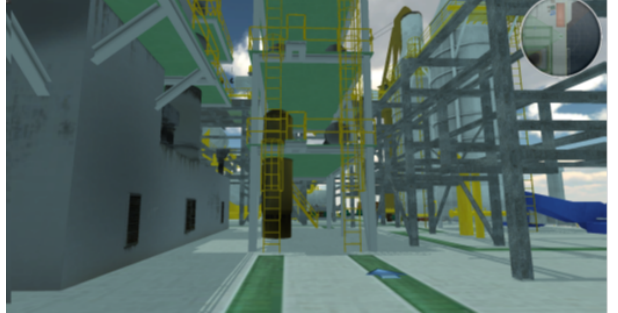
Figure 14. Screenshot of SimUEP- AmbSim